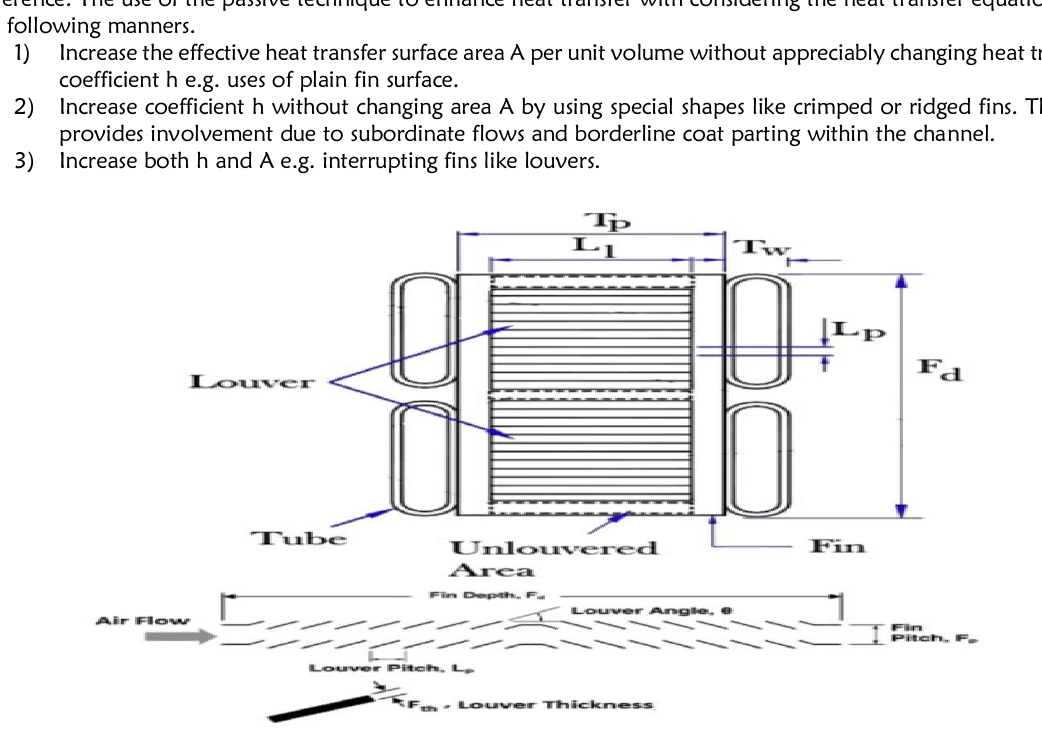
Figure 1: Typical louver fin pattern